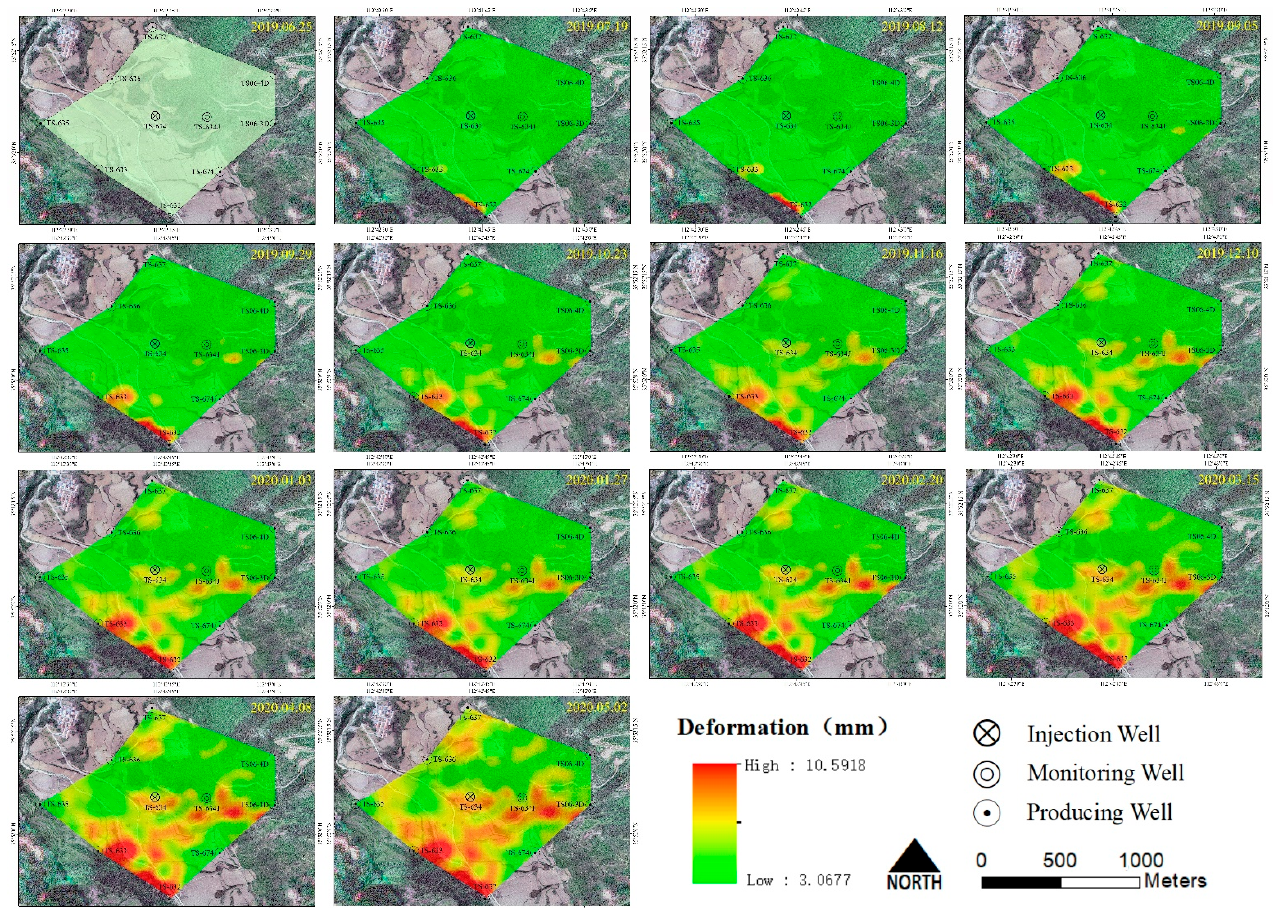
Figure 7. The accumulated surface deformation superimposed on the UAV model of 25 June 2019 for every 24-day interval for about a year before CO 2 was injected.